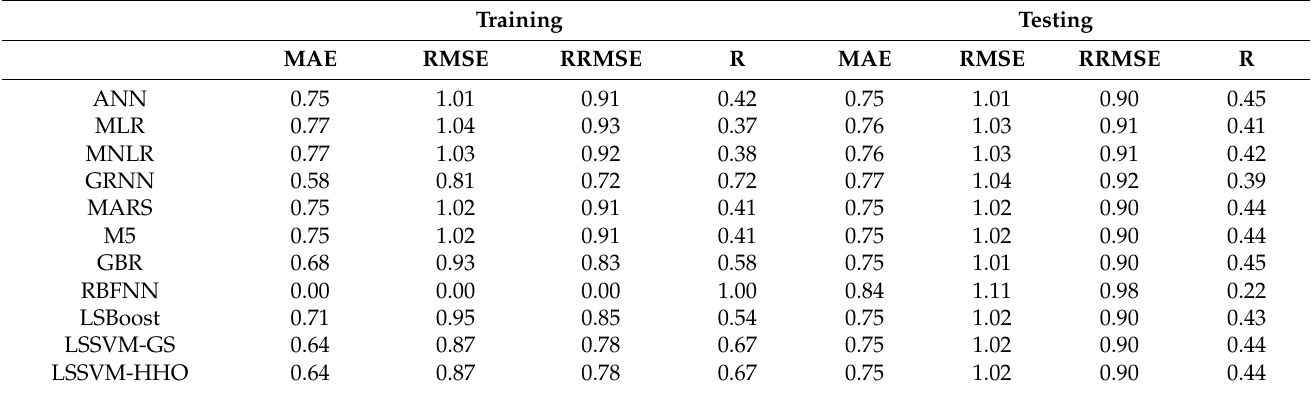
Table A6. Results of modeling WS with the base algorithms at the Kashmar station. Training